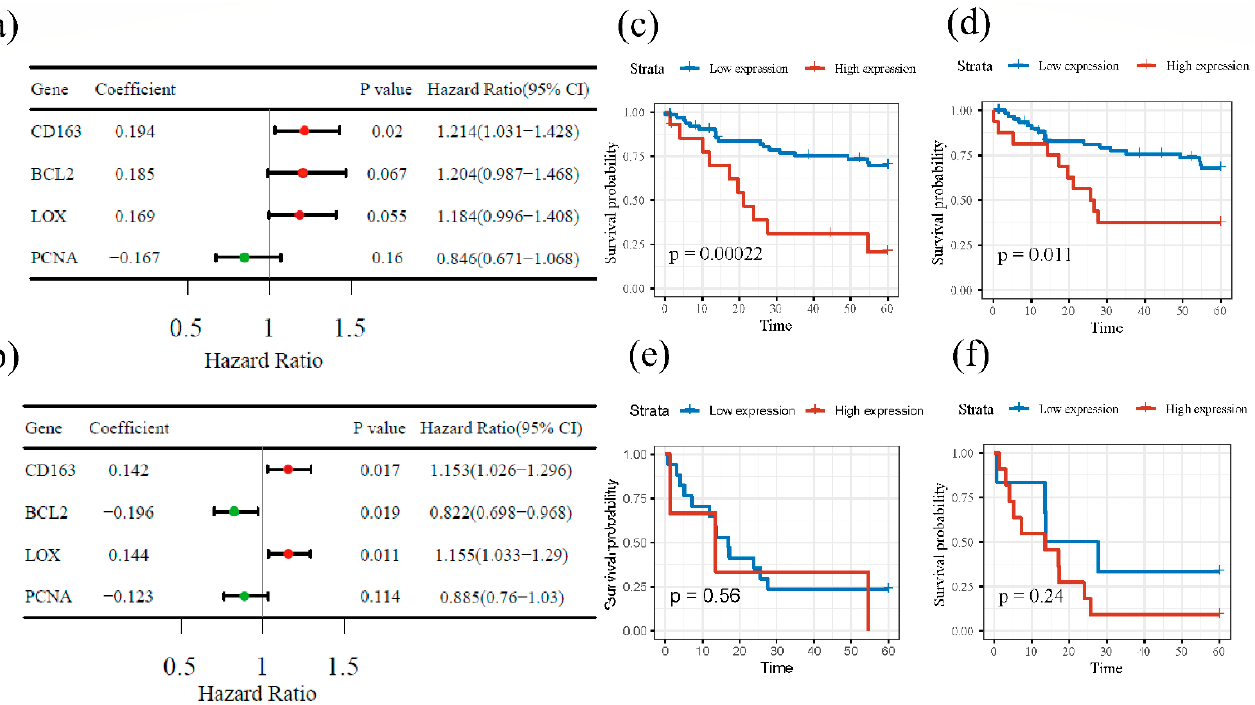
Figure 4. Forest map of four intersectional gene hazard ratios and confidence intervals (CI). Green block means positive prognostic factor, and red means negative prognostic factor. ( a ) Data from TCGA and ( b ) data from GSE39582. K-M survival curves show CD163 expression in relation to survival probability of colorectal cancer patients from several Swedish hospitals. ( c ) K-M survival analysis of tumor-tissue cellular CD163 differential expression; ( d ) K-M survival analysis of tumor-tissue stromal CD163 expression; ( e ) K-M survival analysis of normal-tissue cellular CD163 expression; ( f ) K-M survival analysis of normal-tissue stromal CD163